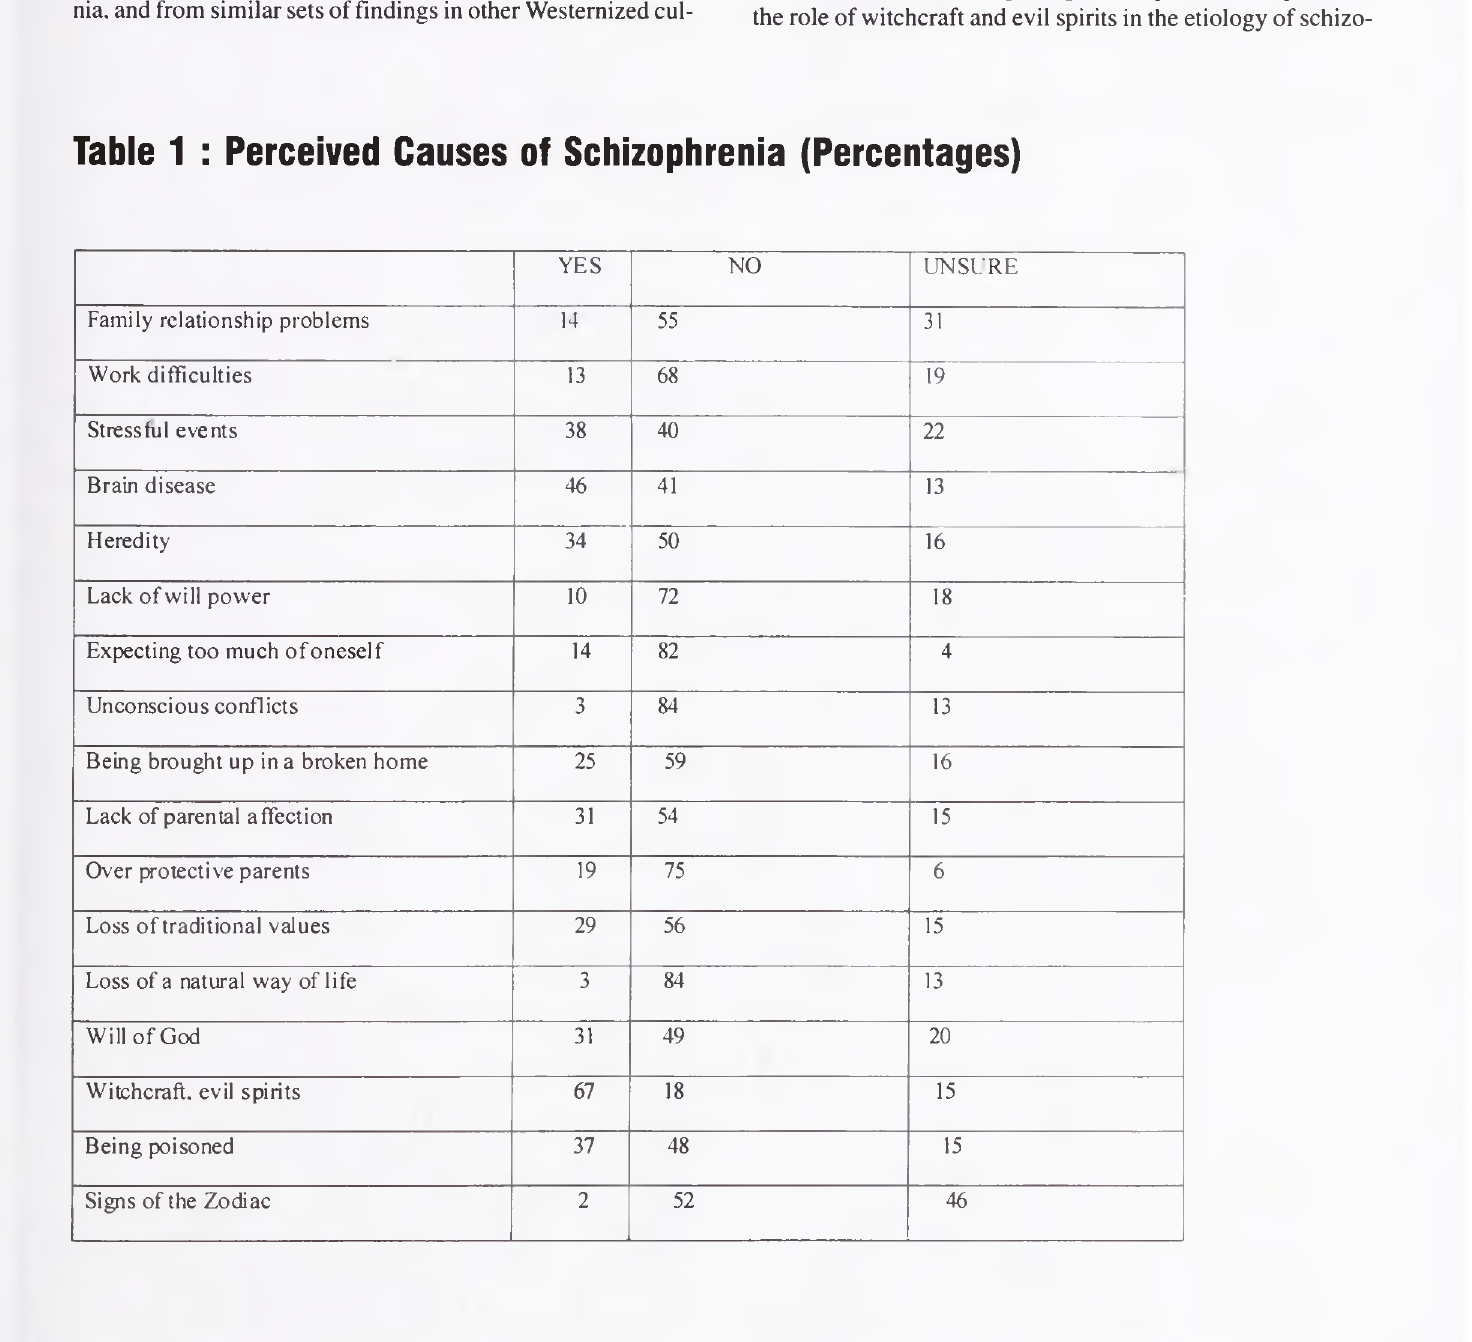
Table 1 : Perceived Causes of Schizophrenia